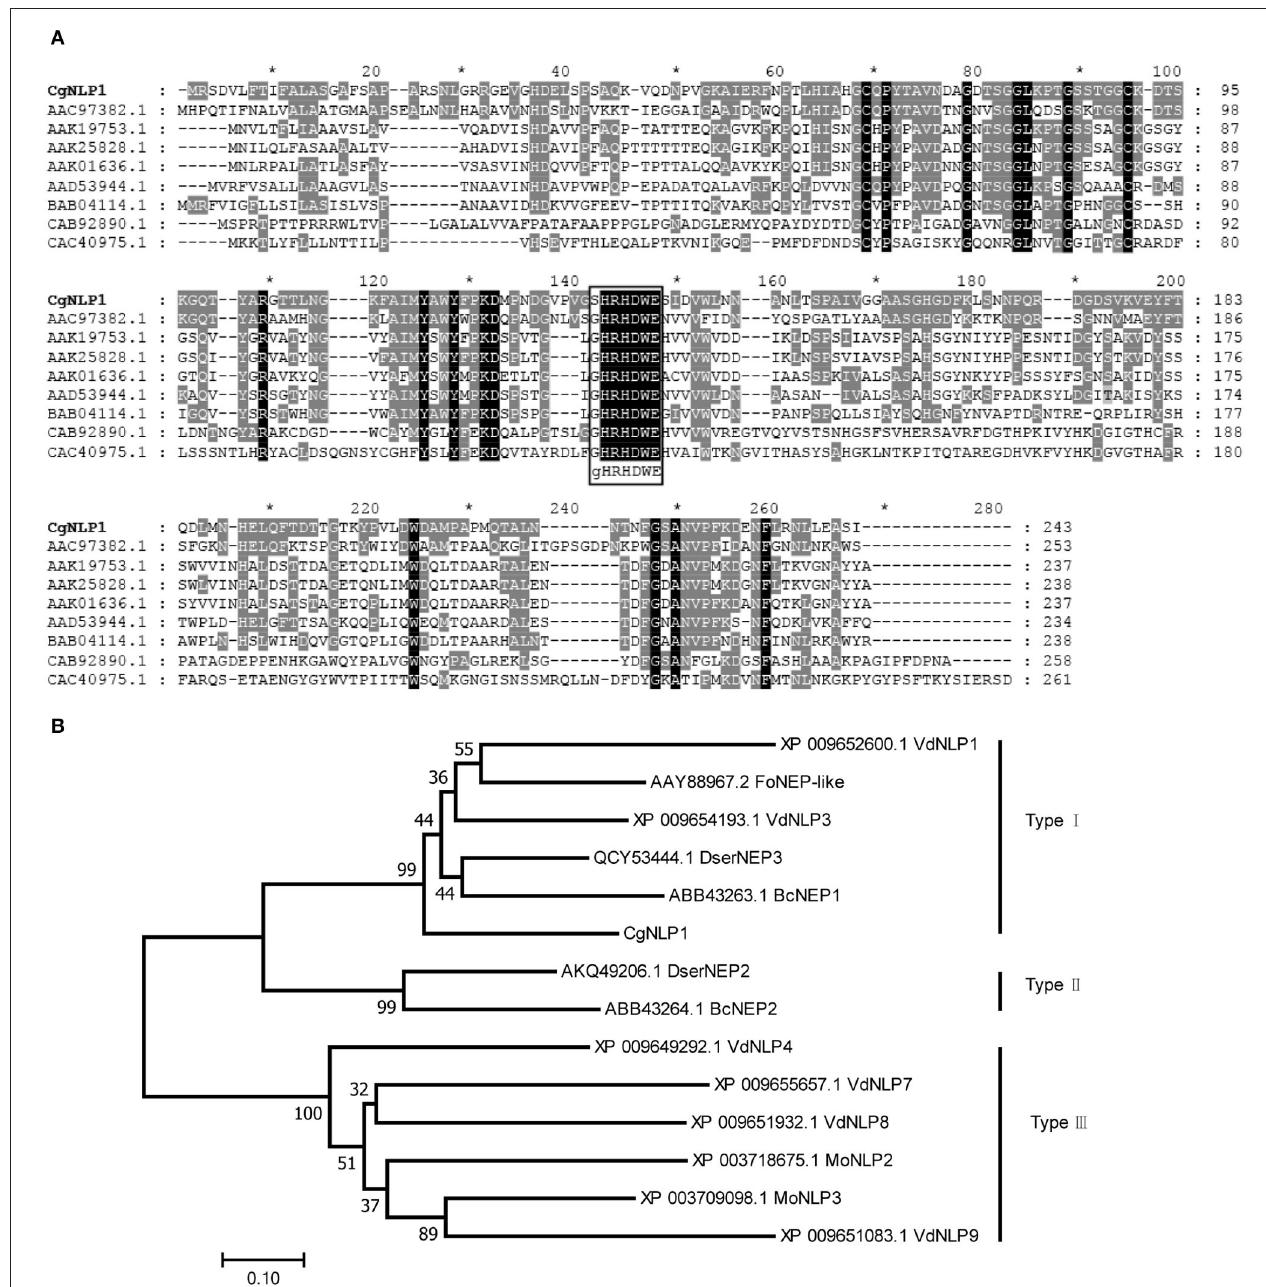
FIGURE 1 | Multiple sequence alignment and phylogenetic analysis of CgNLP1. (A) Alignment of the necrosis- and ethylene-inducing protein 1 (Nep1)-like protein (NLP) from different microorganisms. Shading indicates regions of conservation in all (black), the same amino acid as CgNLP1 (gray) of sequences. NLPs used for alignment are from Fusarium oxysporum (AAC97382.1), Pythium aphanidermatum (AAD53944.1), Phytophthora infestans (AAK25828.1), Phytophthora parasitica (AAK19753.1), Phytophthora sojae (AAK01636.1), Streptomyces coelicolor A3(2) (CAB92890.1), Alkalihalobacillus halodurans C-125 (BAB04114.1), and Vibrio pommerensis (CAC40975.1). (B) Phylogenetic tree of CgNLP1 with different types of NLPs in fungi. VdNLP1 and VdNLP3 are from Verticillium dahlia , DserNEP3 is from Diplodia seriata , FoNEP-like is from Fusarium oxysporum , BcNEP1 and BcNEP2 are from Botrytis cinerea , DserNEP2 is from Diplodia seriata , PcNPP1 is from Phytophthora cinnamomi , MoNLP2 and MoNLP3 are from Pyricularia oryzae , and VdNLP4, VdNLP7, VdNLP8, and VdNLP9 are from Verticillium dahlia . domains, which were typical features of MYB TFs. The results HbMYB8-like gene was amplified by RT-PCR and verified by of multiple sequence alignment ( Supplementary Figure S5 ) sequencing. The result showed that the full-length cDNA of the and phylogenetic tree ( Supplementary Figure S6 ) showed that HbMYB8-like gene was 1,183 bp with a 903 bp ORF encoding HbMYB8-like protein had typical adjacent repeats R2R3 and 300 amino acids. The HbMYB8-like protein contained two SANT